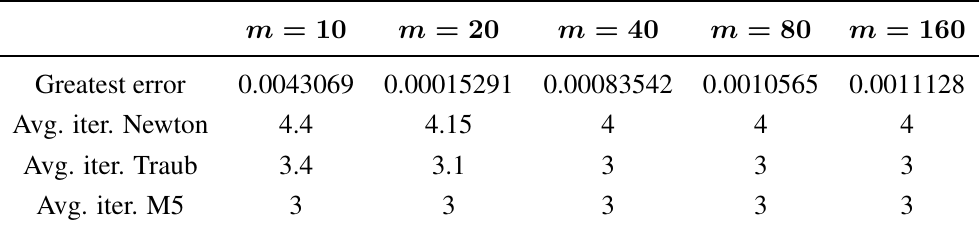
Table 2. Comparison of the GE and methods iterations for different amount of time